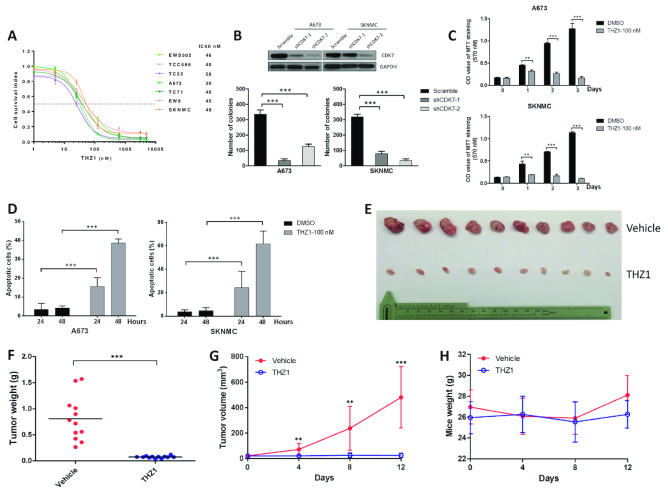
THZ1 exhibits strong anti-neoplastic property against Ewing sarcoma. (A) Dose-response curves of 7 Ewing sarcoma cell lines to THZ1 treatment for 72 hr. IC50 values were measured by MTT assay. Data were represented as mean ± SD of three replicates. (B) A673 and SKMNC cells stably expressing either CDK7-specific shRNAs or scrambled shRNA control (Scramble) were subjected to immunoblotting assay (upper panel) and colony formation assay (lower panel). Bars represent mean ± SD of three replicates (*** P < 0.001). (C) MTT assay and (D) apoptosis assay showing the effect of THZ1 treatment on Ewing sarcoma cell lines at indicated time points. Bars represent mean ± SD of three replicates (**P < 0.01, ***P < 0.001). (E–G) THZ1 suppressed the growth of A673 xenografts. (E) Images and (F) weights of resected tumors from both vehicle and THZ1 treatment groups at the end point. (G) Tumor volumes of mice treated either with vehicle or THZ1. Data represent mean ± SD of each group (**P < 0.01, ***P < 0.001). (H) No significant loss of body weight was observed in mice during treatment.